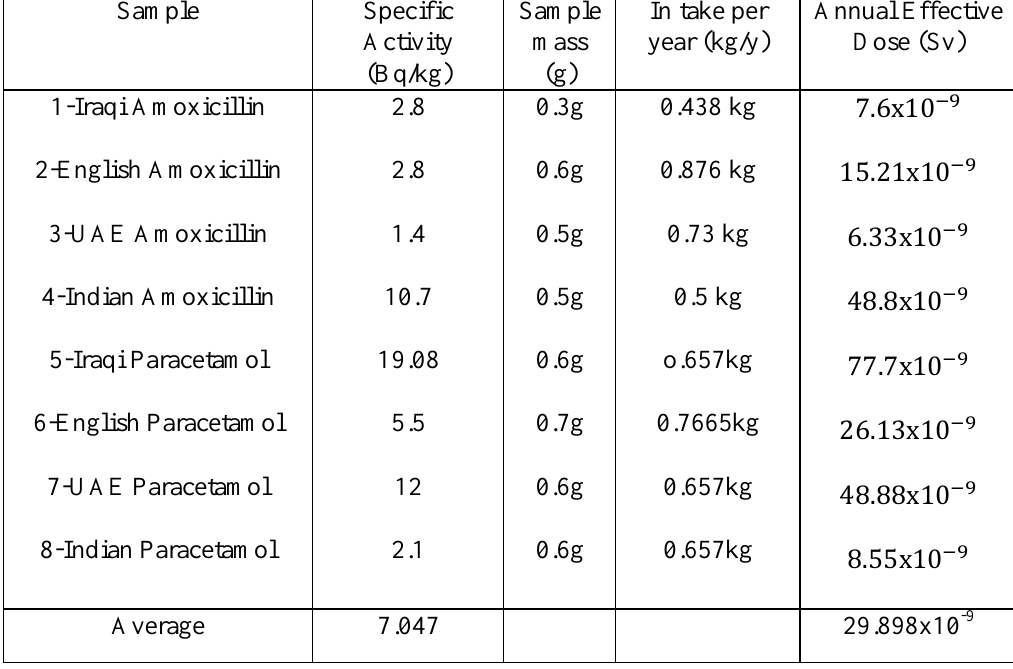
Table 2: Specific activity, sample mass, in take mass per year and annual effective dose of 40 K for all samples.